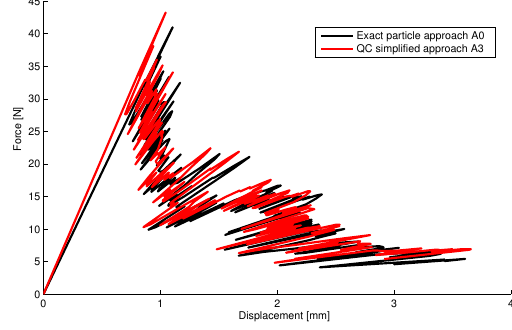
Figure 3. Force-displacement diagrams computed with exact particle approach A0 (black) and with QC approach with local anisotropic homogenization A3 (red).